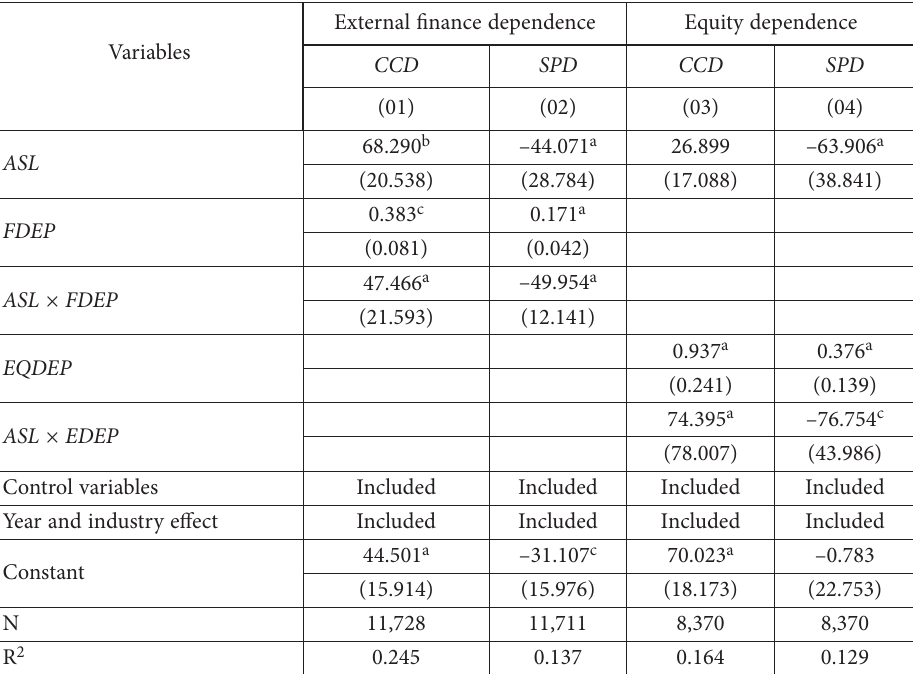
Table 8. Financial flexibility (equity